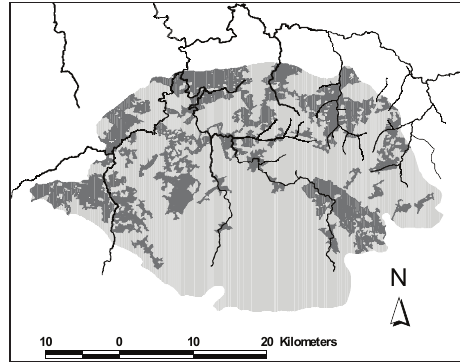
Fig. 2. Dark gray represents remnant areas of poten- tially original Egoli Granite Grassland; perennial rivers